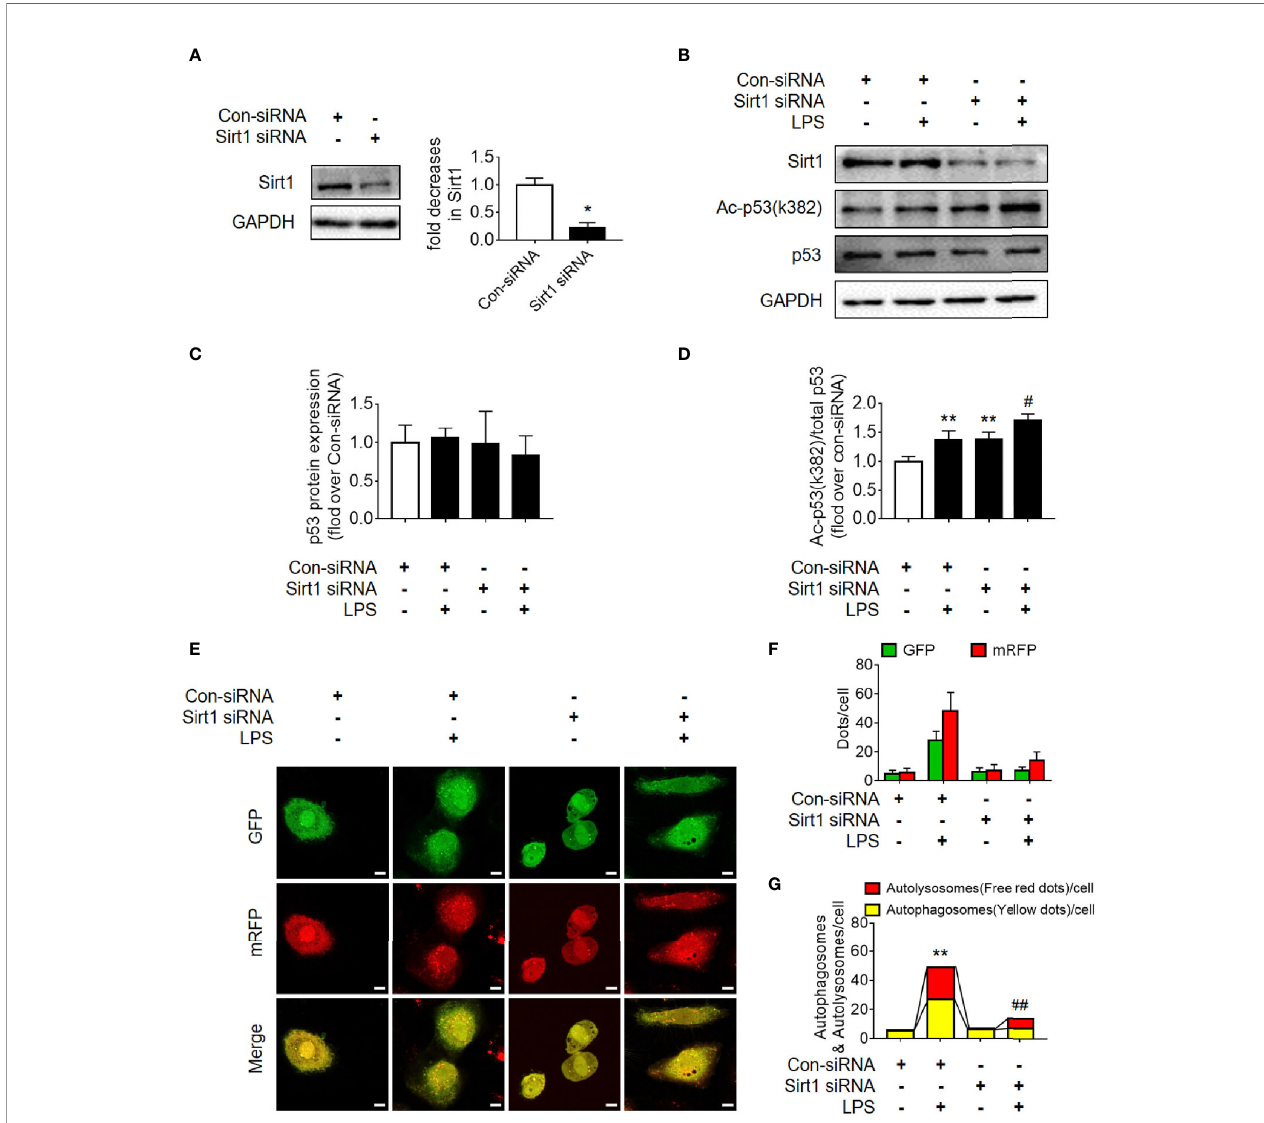
FIGURE 8 | Determination of the effects of Sirt1 small interfering RNA (siRNA) transfection. (A) Con fi rmation of siRNA-mediated Sirt1 knockdown using western blot. Con-siRNA, control siRNA. (B) Representative Western blot of Sirt1, acetylated-p53 (Ac-p53), and p53 in LPS-treated HK-2 cells. (C, D) Densitometric analyses of p53 protein expression and acetylated-p53 (Ac-p53). n = 3. (E) Effects of Sirt1 knockdown on autophagic fl ux assessed by cellular immunoassay following LPS stimulation in different groups (magni fi cation ×630 and scale bar = 10 µm). (F) Effect of Sirt1 knockdown on the numbers of GFP and mRFP counts per cell. (G) Effect of Sirt1 knockdown on autophagosomes and autolysosomes per cell. * p < 0.05, ** p < 0.01 vs. con-siRNA group; # p < 0.05, ## p < 0.01 vs. con-siRNA + LPS group. Results represent at least three independent experiments. LPS, lipopolysaccharide; GFP, green fl uorescent protein; mRFP, monomeric red fl uorescent